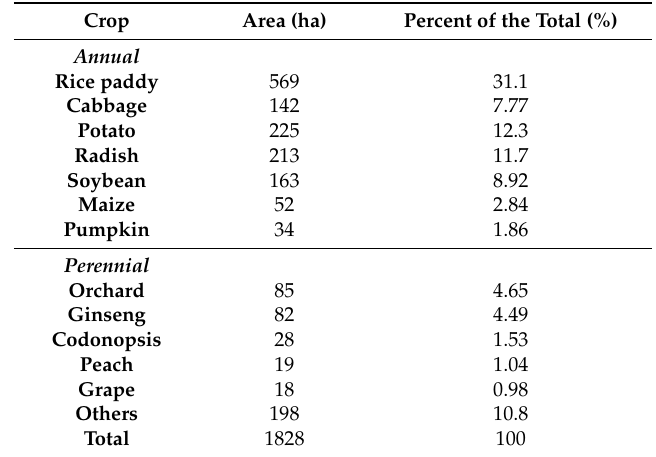
Table 2. Agricultural land use in the Haean watershed (2012) [14].